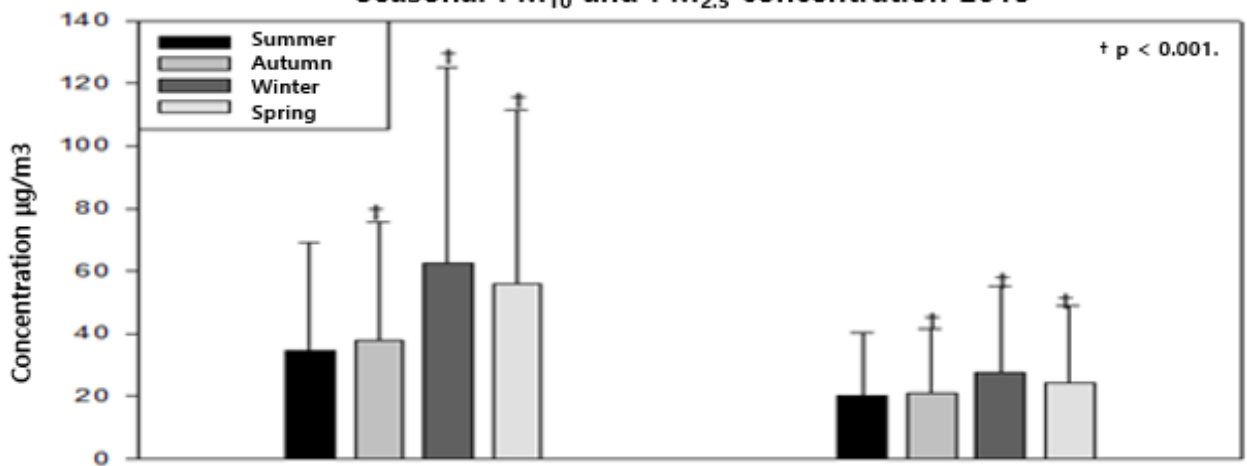
Figure 1. Correlation between the concentration (log-linear) of seasonal fine dust (PM10 and PM2.5) and the Seoul area (2015).